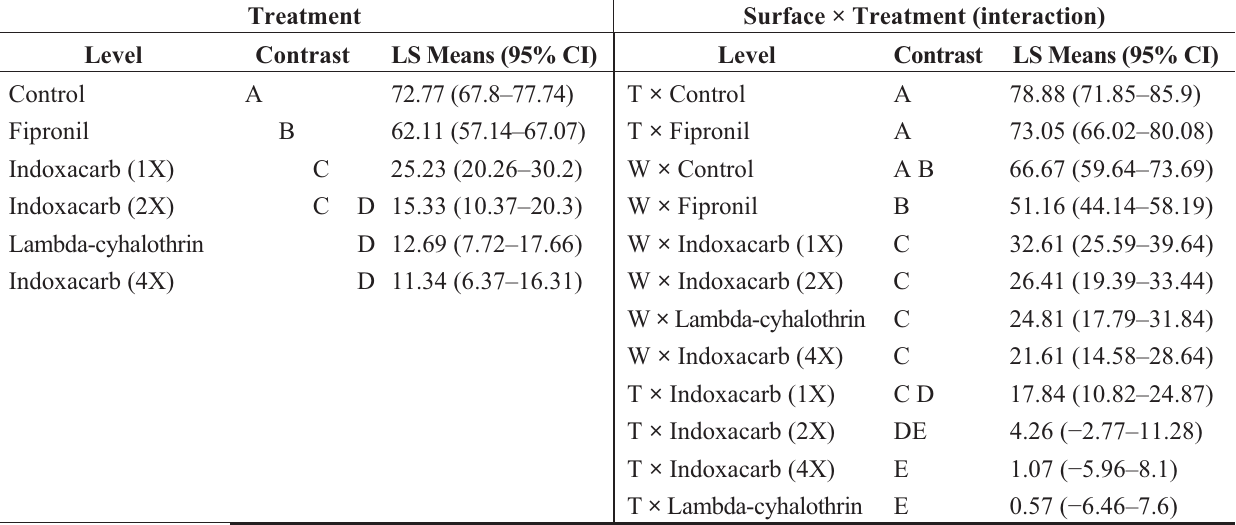
Table 3. Results of post-hoc Tukey’s HSD tests on significant treatment and interaction terms of our regression model for dark rover ant percent survival after exposure to insecticide treated surfaces. Levels not connected by the same letter are significantly different at the 0.05 level. The least square means of the B. patagonicus survival and their 95% confidence intervals are